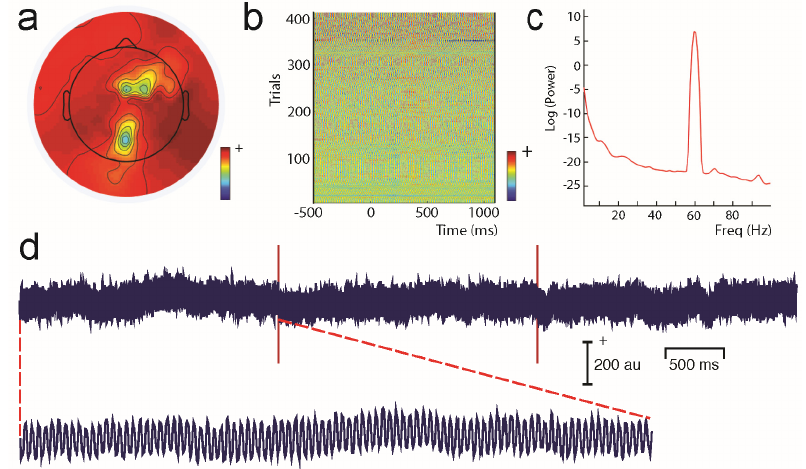
Figure 6. Line noise changes during an experiment. ( a ) Topographic distribution of 60-Hz line noise artifact in EEG data, as identified with an independent component analysis (ICA) map. The bizarre topography of the artifact reflects the likely difference in EEG electrode impedances across the head. The color scale depicts arbitrary units. ( b ) Compressed display of ICA time courses over the entire experiment shows an increase in the size of the artifact over time. Trials increment from bottom to top, and the artifact is more clearly seen as blue and red colors at the top of the display. The color scale depicts arbitrary units. ( c ) Power spectrum of the ICA component shows a clear peak at 60 Hz. ( d ) Time course of the ICA component across three epochs shows the “fuzzy” appearance of line noise that is typical in EEG recordings. The bottom trace shows an expanded version of the signal with a clear periodic form as a function of time.